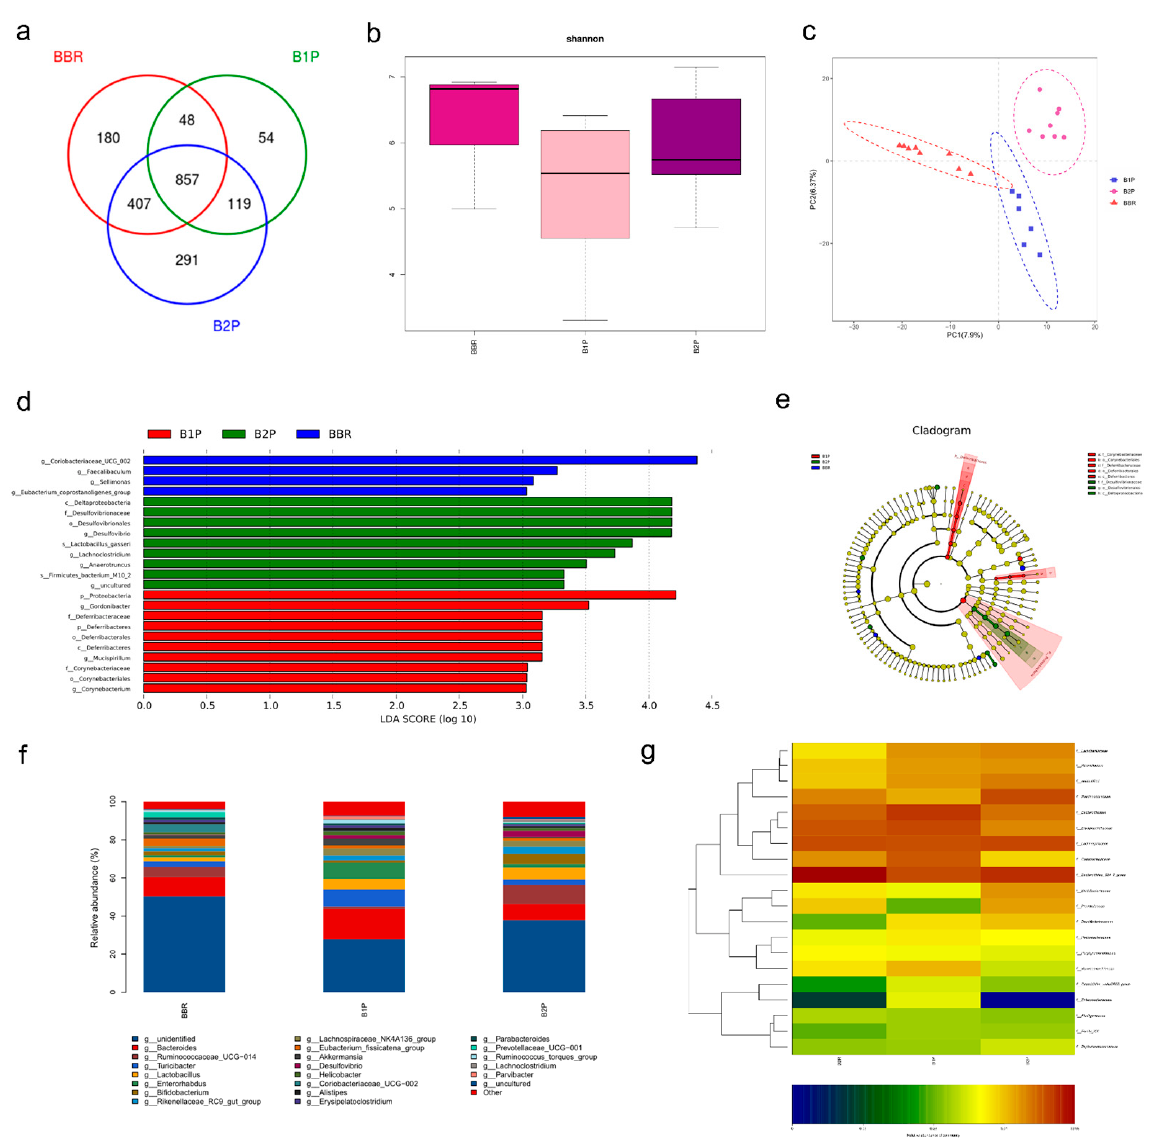
Figure 6. 16S rRNA gene sequencing analysis of gut microbiota regulated by combined BBR and PT. ( a ) Venn diagram displayed the degree of overlap of bacterial OTUs. ( b ) Shannon index showed the α –diversity of the microbial community. ( c ) NMDS analysis showed the β –diversity of gut microbiota. ( d ) Linear discriminant analysis (LDA) showed the significantly abundant microbiome altered at levels from phylum to genus. ( e ) Cladogram exhibited the difference in richness and the group with a significant difference in abundance. ( f ) Community histogram showed the compositional discrepancy between various groups at the genus level. ( g ) Heatmap showed the changes in relative abundance of microbial compositional profiling at the family level. 3. Discussion The DSS-induced mouse colitis model, as the most proven and widely applicable technology among IBD modeling methods [21], was deemed suitable for investigating the pathogenesis and therapeutic option of UC. During the process of DSS intervention, selected DSS aqueous solutions with different concentration gradients were used for acute